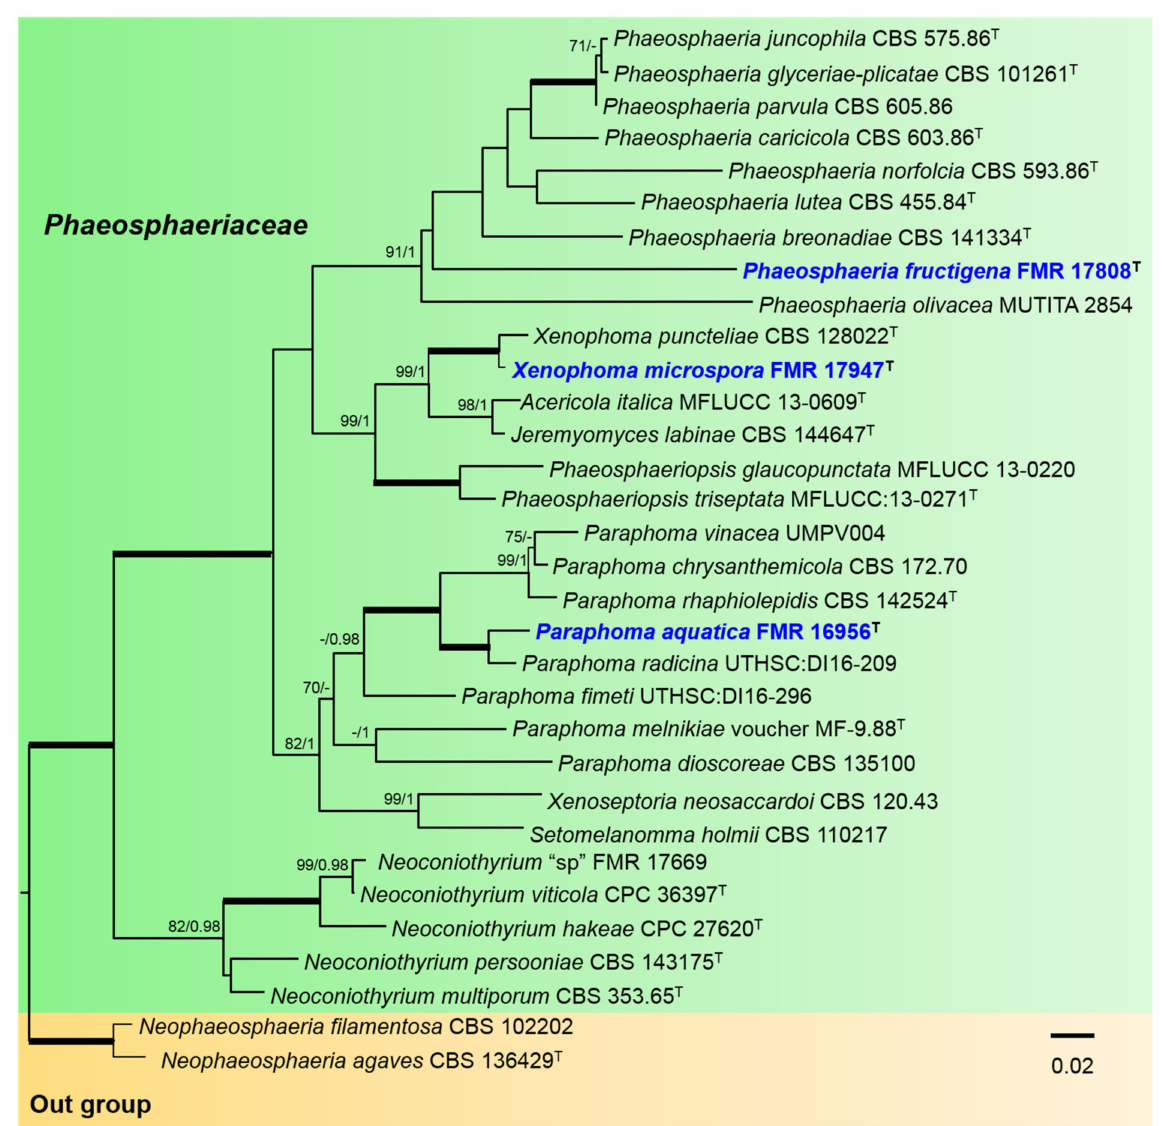
Figure 2. Phylogenetic tree inferred from a Maximum likelihood analysis based on a concatenated alignment of ITS, rpb2, tub2, and tef-1 sequences of 32 strains representing 30 species of Phaeosphaeriaceae . The Bayesian posterior probabilities (PP) above 0.95 and the RAxML bootstrap support values (BS) above 70% are given at the nodes (PP/BS). Fully supported branches (1 PP/100 BS) are indicated thicker lines. Newly proposed taxa are given in blue. Type strains are indicated by a superscript T. The tree was rooted with Neophaeosphaeria agaves CBS 136429 and N. filamentosa CBS 102202. Alignment length 2256